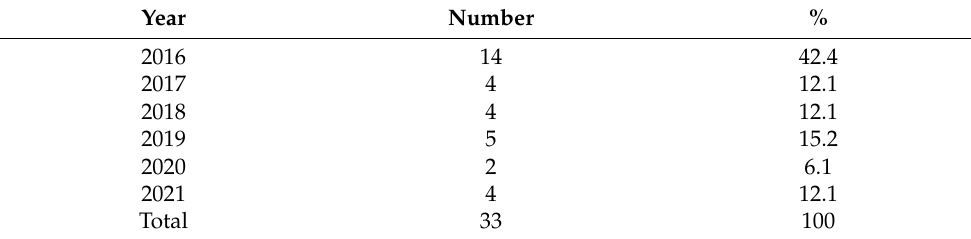
Table 1. Distribution of the partnerships signed between the Beekeepers Cooperative Association-Al- Baha and other actors from 2016 to